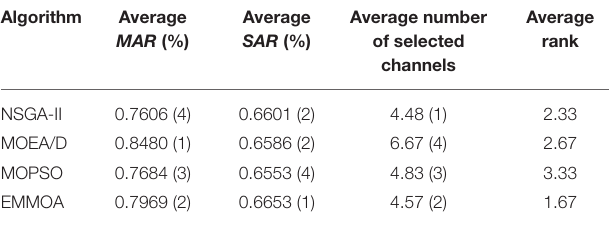
TABLE 4 | Average results obtained by all algorithms.